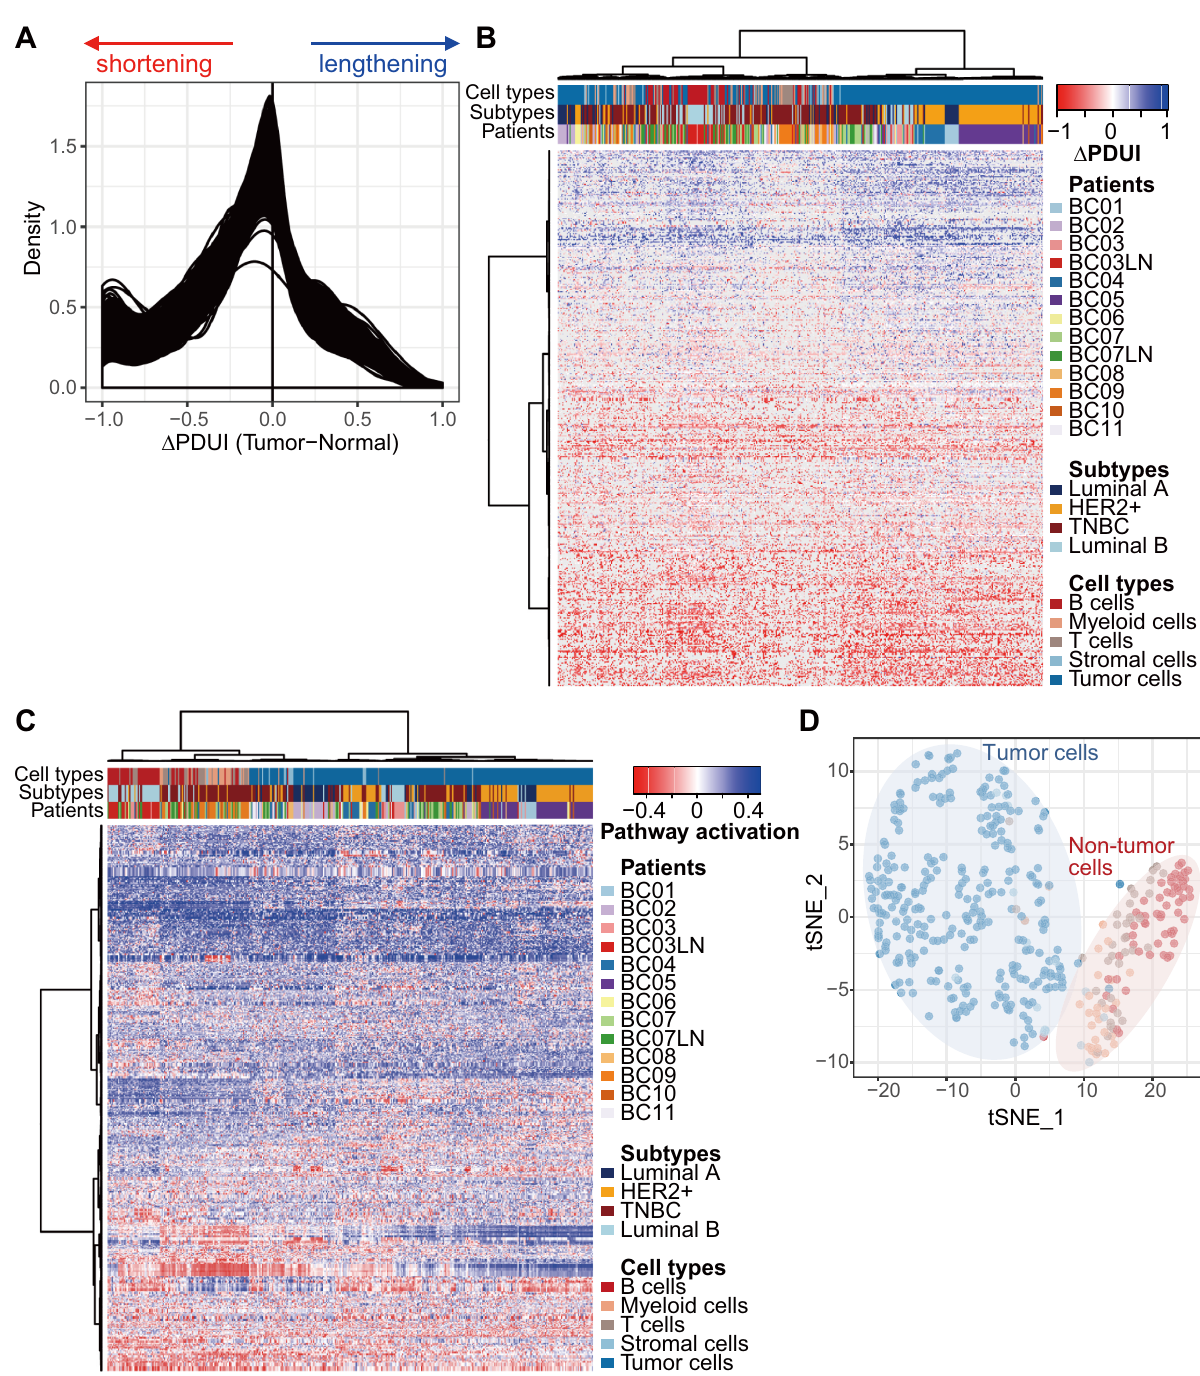
Fig 1. Different APA patterns between tumor and non-tumor cells. (A) The signals of APA ( Δ PDUI calculated by DaPars) for all genes were shifted toward 3’UTR shortening in 515 single cells derived from 11 breast cancer patients (BC01-11). We followed the labels for the patients and cell types pre-defined to original datasets [14]. BC; Breast cancer, LN; Lymph nodes. Hierarchical clustering was performed using APA estimates (B) for genes and (C) gene sets on individual cells derived from breast cancer patients. Only 419 cells with at least 542 (10% of total genes) detected genes were selected for further analysis. A total of 1,452 genes and 3,353 gene sets showed the signals of APA on 419 cells. Among theme, 453 genes and 555 gene sets were selected as variable components for hierarchical clustering and dimensional reduction, respectively (see Methods). (D) Unsupervised tSNE on the gene set-level APAs separating 280 tumor and 139 non-tumor cells (immune and stromal cells) in breast cancer. Individual cells are colored for samples, consistent with the coloring in Fig 1B and